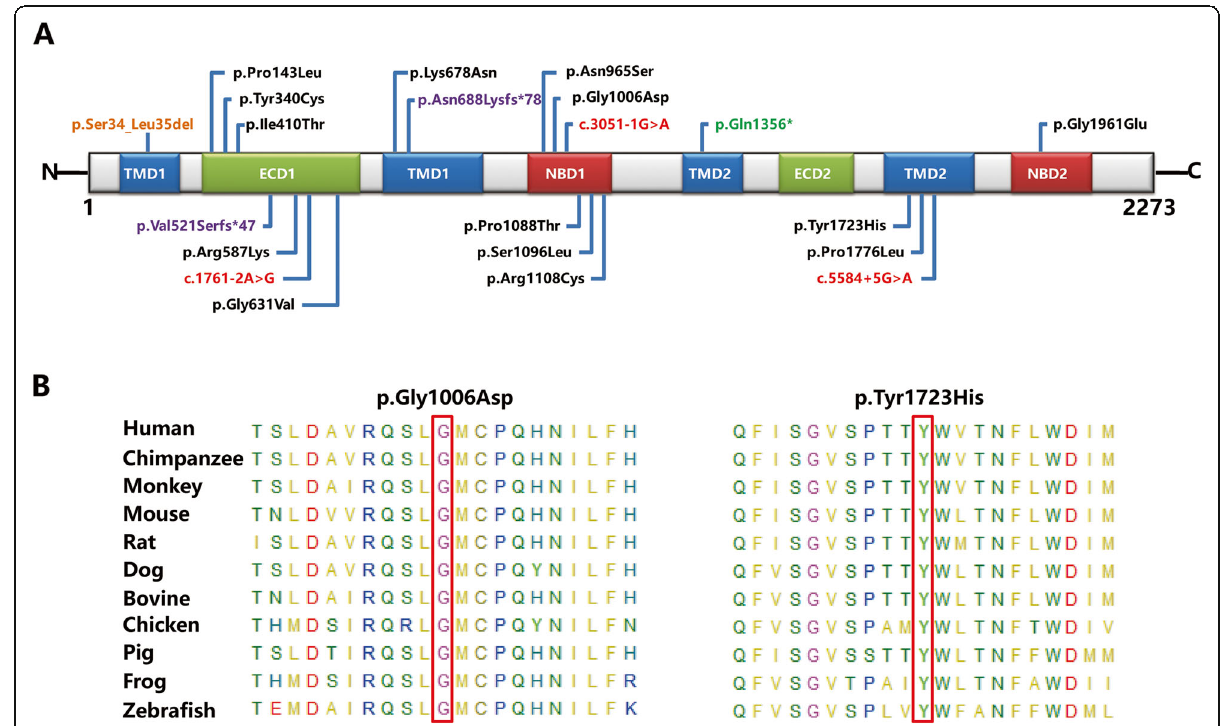
Fig. 3 Distribution of the detected mutants in the ABCA4 functional domains and conservation analyses. a Location of 21 mutants in six functional domains. Black: missense mutant. Red: splicing mutant. Purple: frameshift mutant. Green: nonsense mutant. Yellow: small deletion mutant. b Multiple orthologous sequence alignment displaying the conserved amino acid residues (Glycine 1006 and Tyrosine